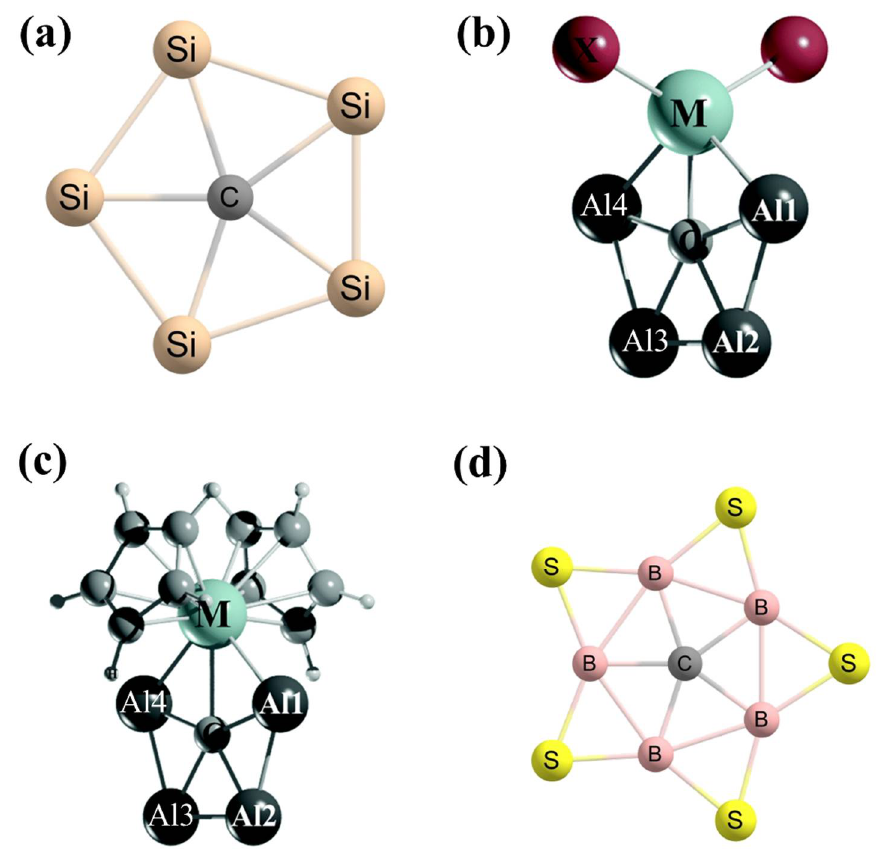
Figure 26. ( a ) The symmetric structures Si 5 C 2 − and Si 5 C − clusters are ppC species. The monoanionic and dianionic forms have the same shape but different bond lengths. The lowest-energy isomers of ( b ) CAl 4 MX 2 clusters and ( c ) CAl 4 M(C 5 H 5 ) 2 clusters. The global minimum structure of ( d ) CB 5 S 5+ cluster with a ppC.